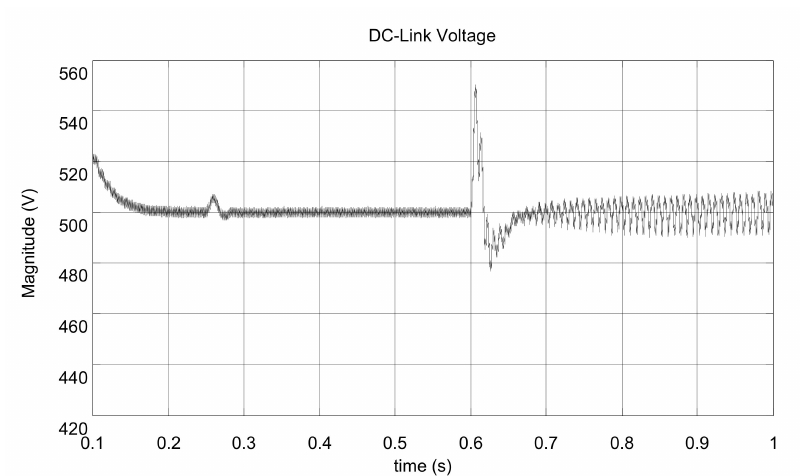
Figure 28. DC-link capacitor voltage under ‘type C’ voltage sag.